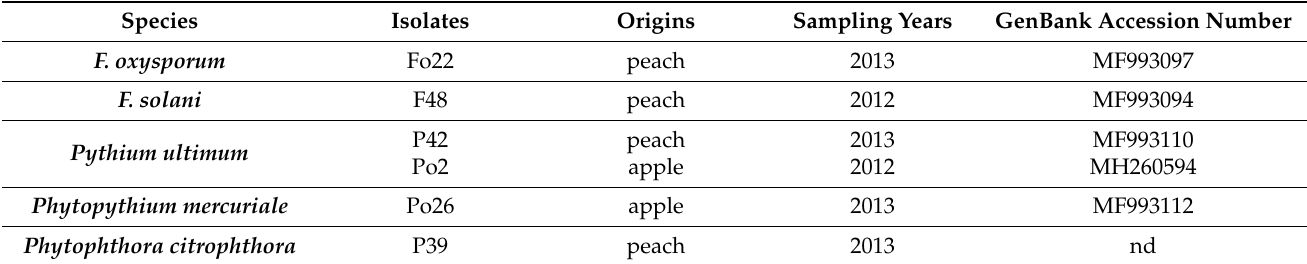
Table 9. Pathogen isolates collected from peach and apple seedling nurseries and used in this investigation. Species Isolates Origins Sampling Years GenBank Accession